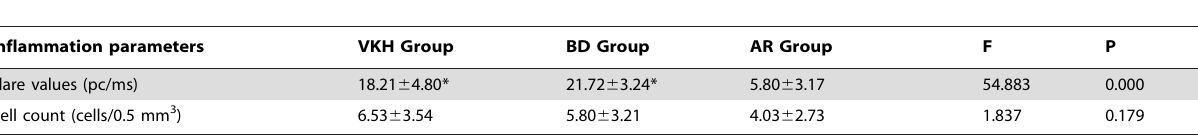
Table 1. Anterior chamber aqueous flare and inflammatory cells counts of the three groups.